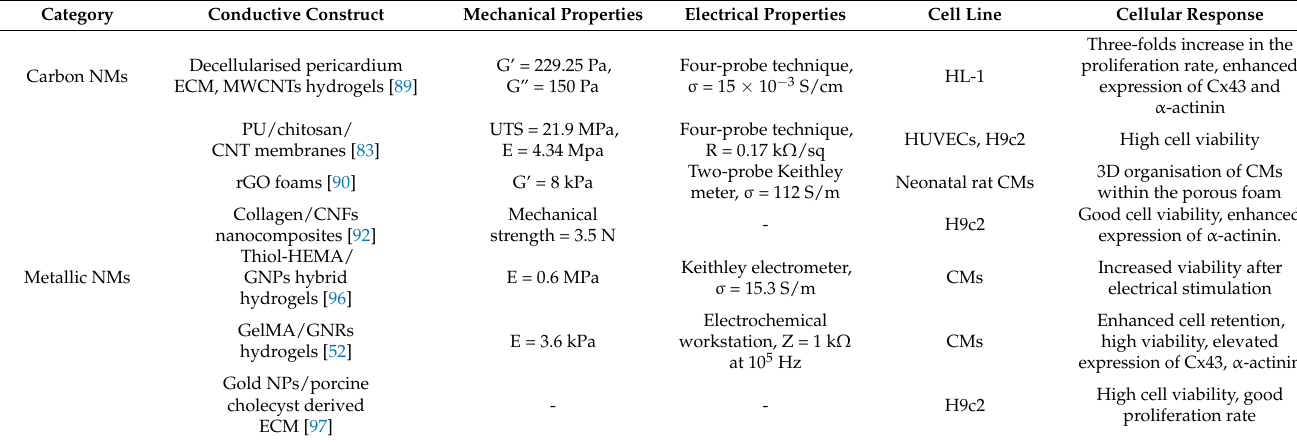
Table 2. Effect of conductive nano-construct on cell viability and